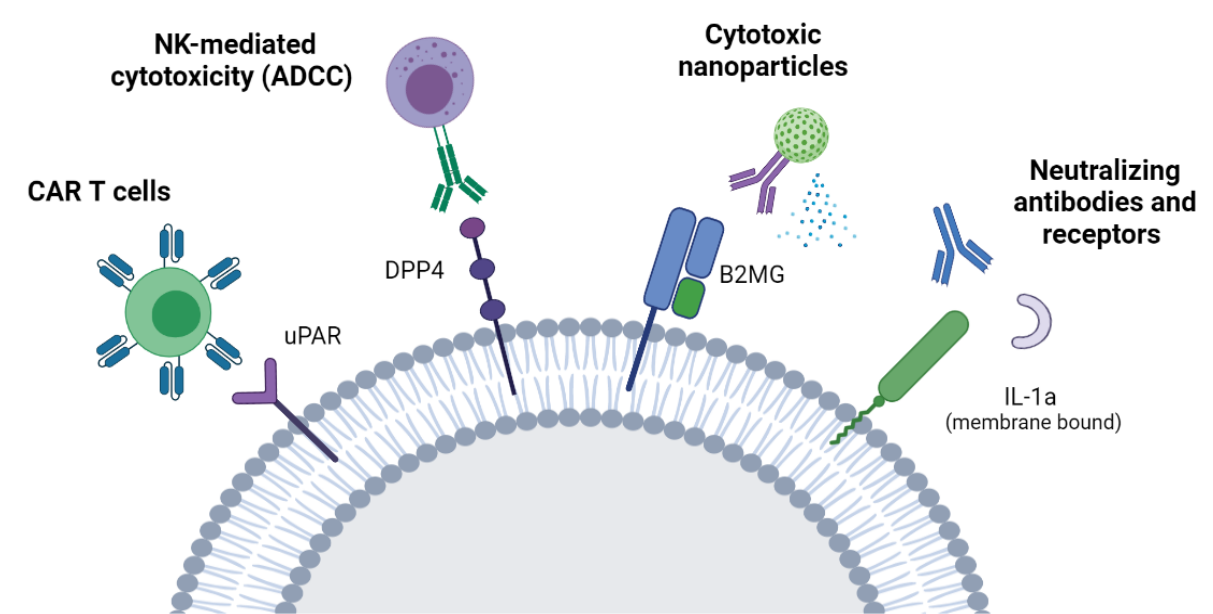
Figure 1. Targeting senescent cells through the senescent surfaceome. A schematic of strategies aimed at the elimination of senescent cells by targeting molecules preferentially expressed on the surface of senescent cells. These approaches include NK-mediated cytotoxicity, CAR-T cells, antibody-conjugated nanoparticles, and neutralizing antibodies or soluble receptors. NK: Natural killer cells. ADCC: Antibody-dependent cellular cytotoxicity. CAR-T cells: Chimeric antigen receptor T cells.